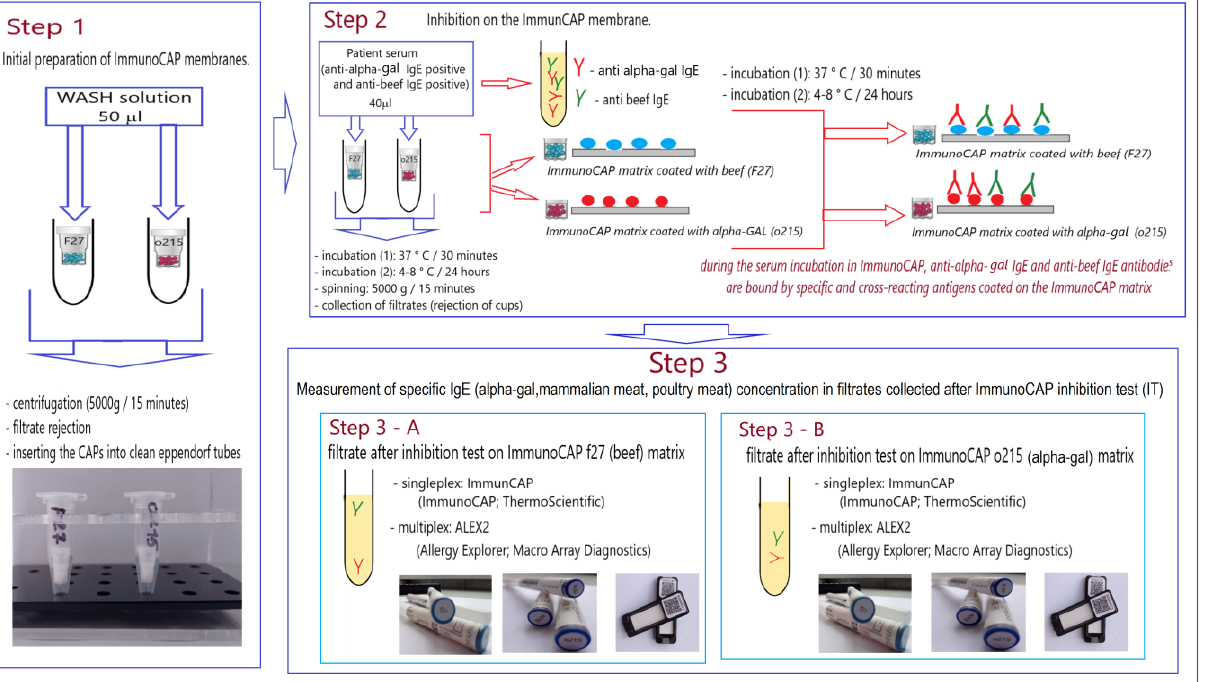
Figure 1. ImmunoCAP inhibition test with o215 (alpha-gal, ImmunoCAP) and f27 (beef, Im- munoCAP)—the experiment scheme. ImmunoCAP)—the experiment